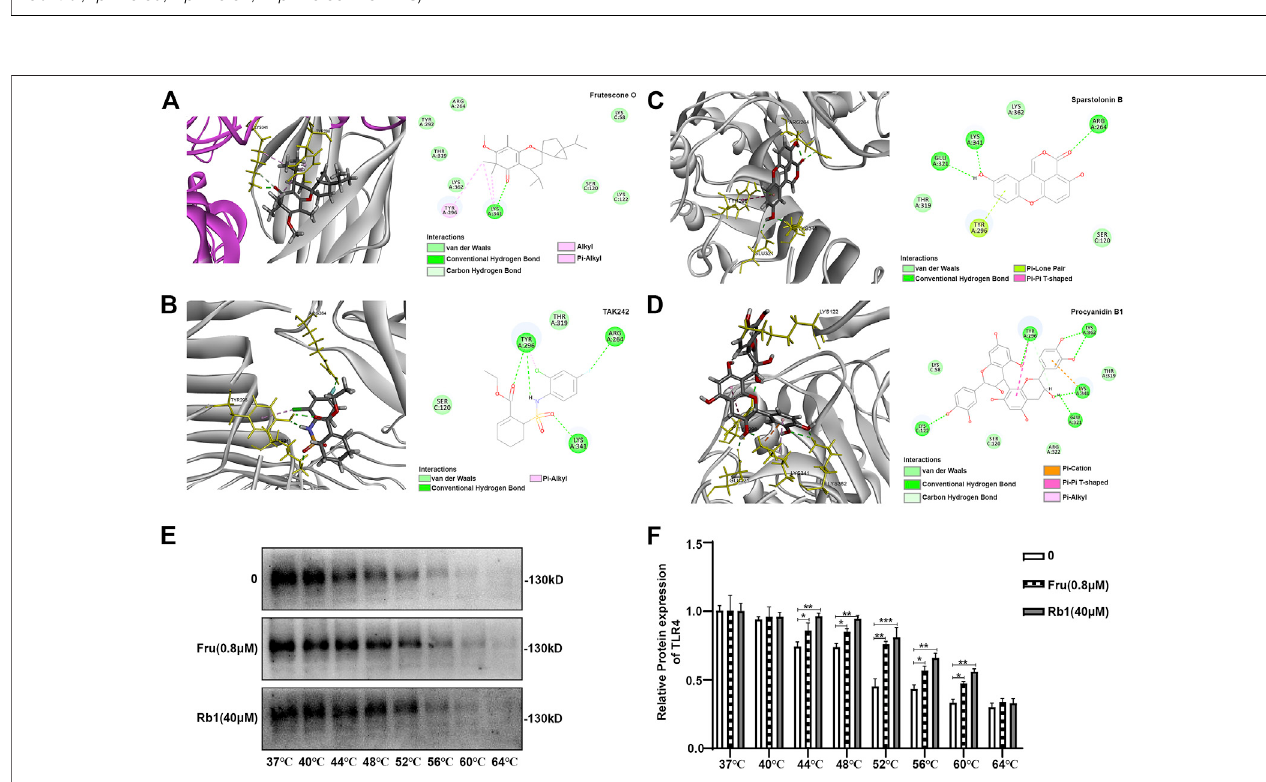
FIGURE 6 | Molecular docking of Frutescone O on TLR4-MD2 complex. (A) The close-up view and 2D view of the sites of Fru in the TLR4-MD2 complex. (B) The close-upviewand2DviewofthesitesofTAK242intheTLR4-MD2complex. (C) Theclose-upviewand2DviewofthesitesofSparstoloninBintheTLR4-MD2complex. (D) The close-up view and 2D view of the sites of Procyanidin B1 in the TLR4-MD2 complex. (E, F) The binding study of TLR4 with Fru (0.8 μ M) by cellular thermal shift assay. Rb1 (40 μ M) served as the positive control and 0 the negative control. Quantitative data was represented as mean ± SD ( n (cid:2) 3, * p < 0.05, ** p < 0.01, *** p < 0.001 vs. negative